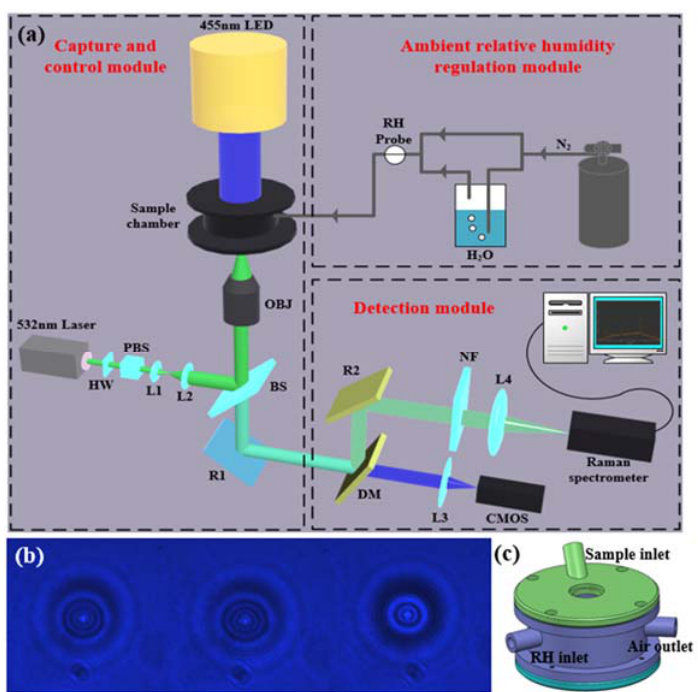
Figure 1. ( a ) Schematic of the microdroplet formation system based on optical tweezers (OTs). HW: half ‐ wave plate; PBS: polarizing beam splitter; L: lens; BS: beam splitter; OBJ: objective; R: reflector; DM: dichroic mirror; NF: notch filter; LED: light ‐ emitting diode; CMOS: complementary metal ‐ oxide semiconductor; RH: relative humidity; N2: nitrogen. ( b ) Photographs of microdroplets captured by optical trap are taken by the CMOS. ( c ) Schematic diagram of the sample chamber.